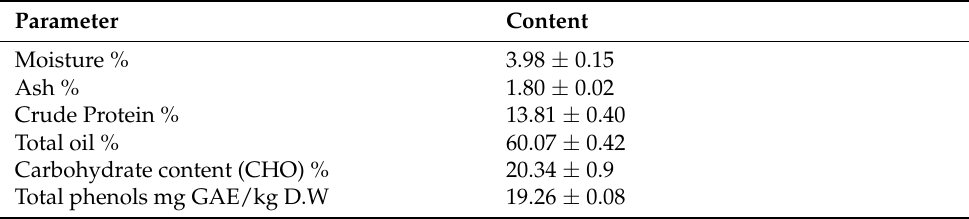
Table 2. Proximate analysis of walnut kernels used in this study.